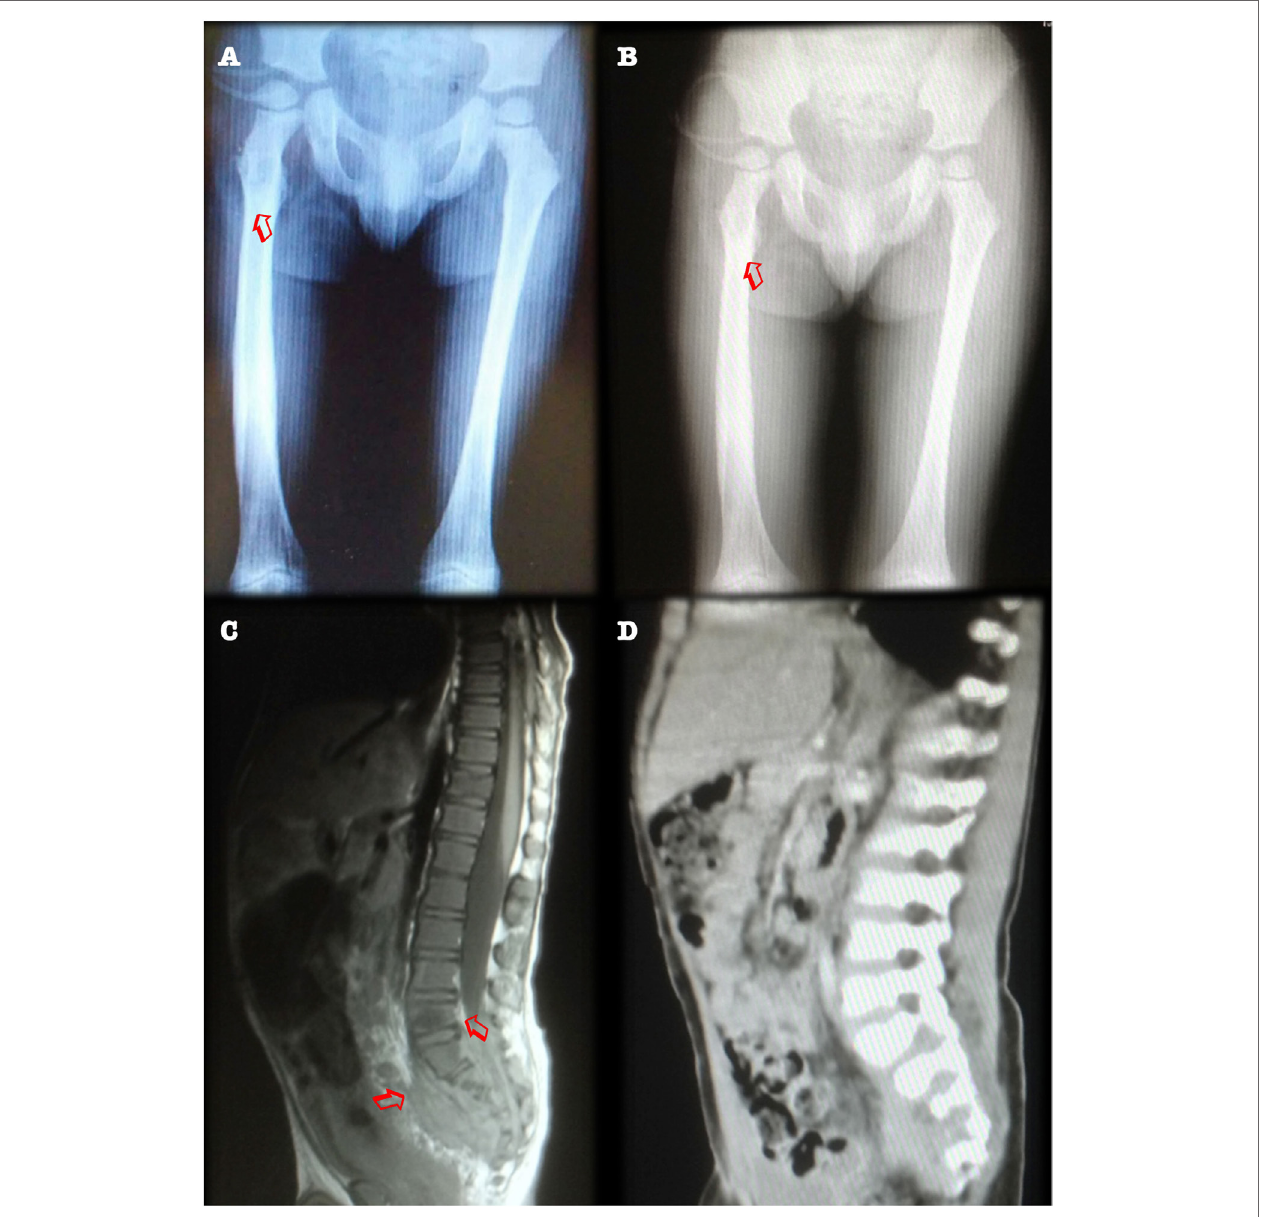
FIGURe 1 | (a) Anteroposterior X-ray film revealing metaphyseal osteolytic lesions in femurs (arrowheads). Contrast with panel (B) . Radiological improvement after 1 year of antimycobacterial drug treatment, with femoral remodeling. (C) CT scan, sagittal view, showing presacral mass and osteolytic lesions of the S3–S4 vertebral bodies (arrowheads). Contrast with panel (D) . Improvement after 1 year of treatment, with vertebral remodeling and decreased antesacral